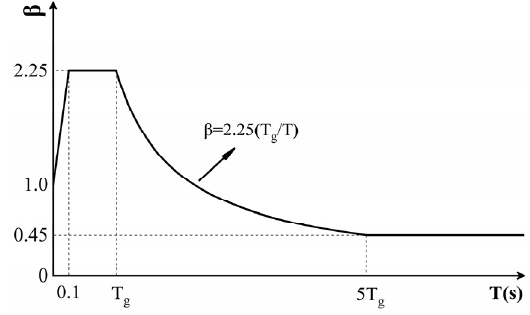
Figure 7. Curve of power amplification factor β .